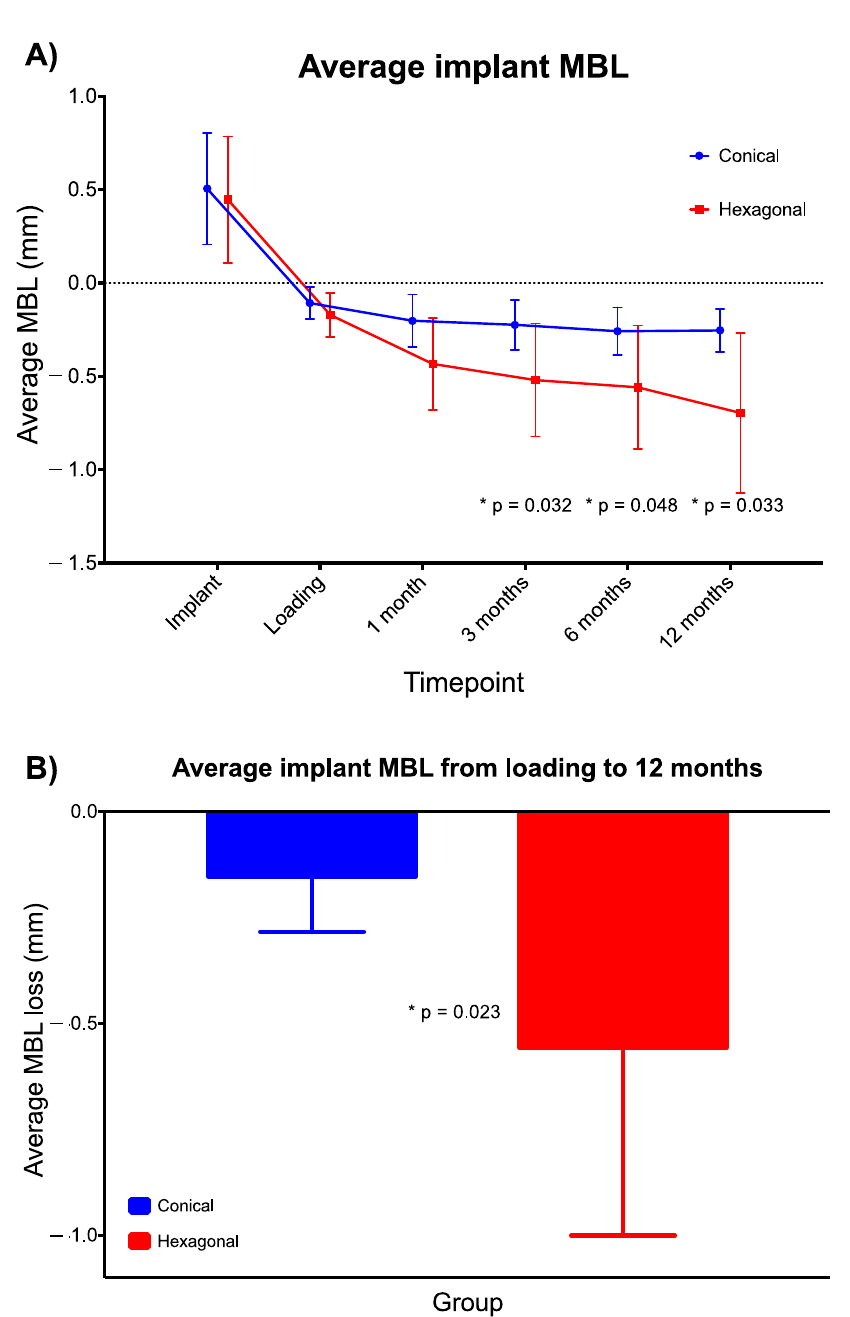
Figure 5. ( A ) Representation of the average implant MBL over time. ( B ) Average implant MBL change from prosthesis delivery to the 12-month follow-up. * Independent samples Mann–Whitney U test. Error bars represent SD.